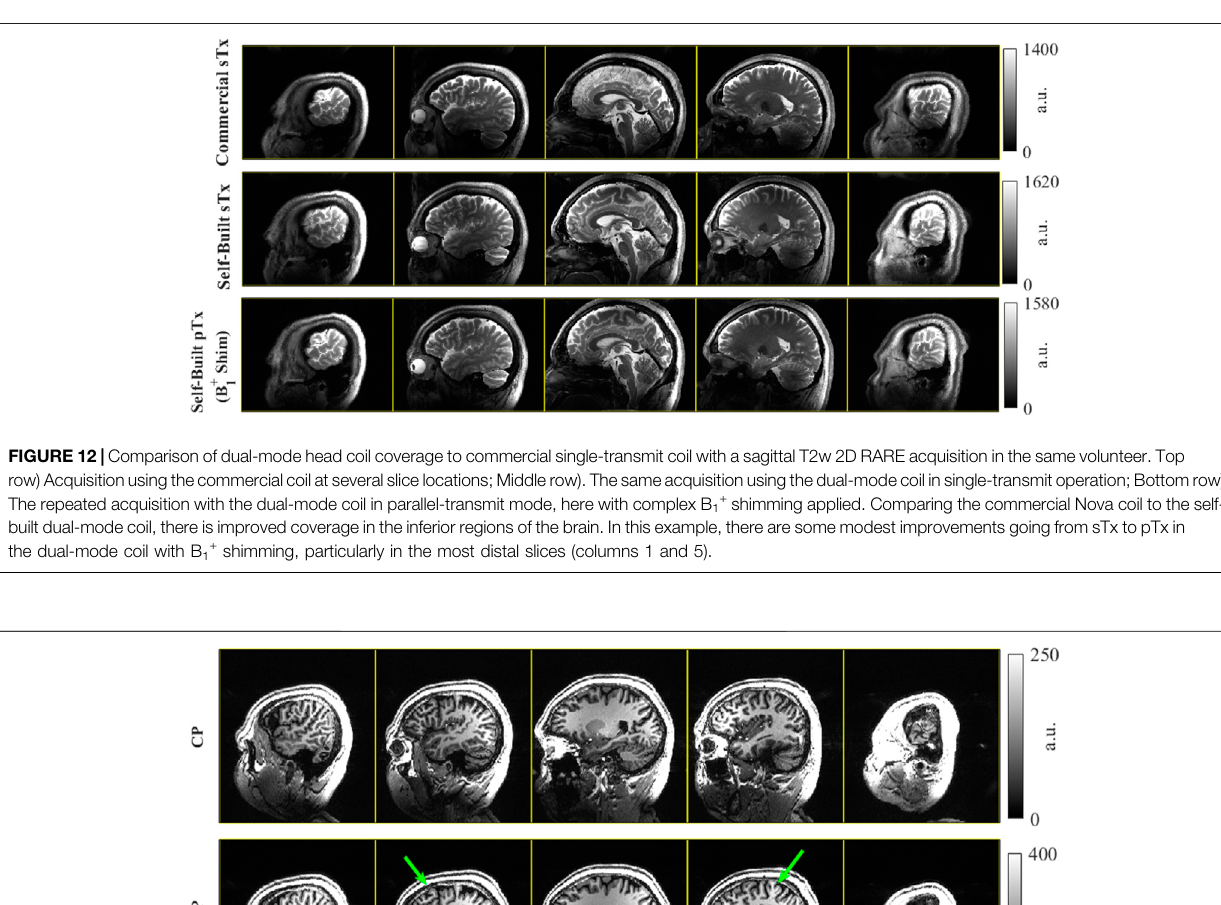
Frontiers in Physics |